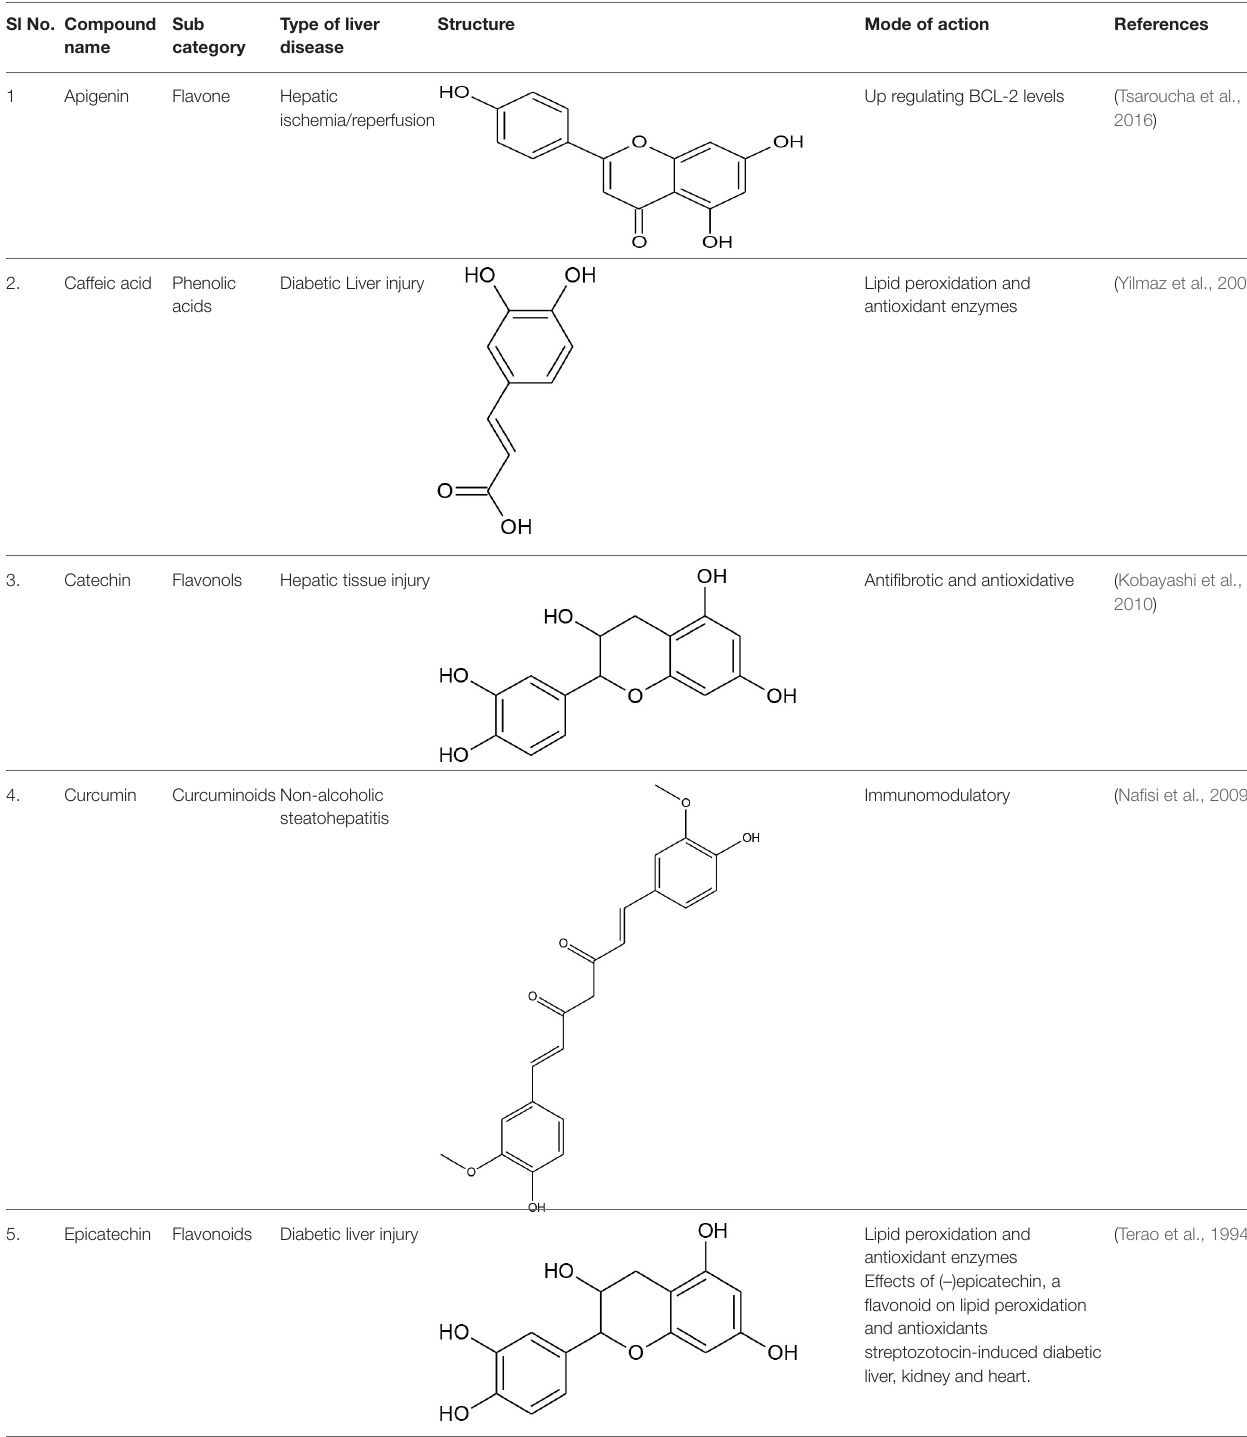
TABLE 1 | List of a few potent natural phenolics and their mode of action imparting hepatoprotective